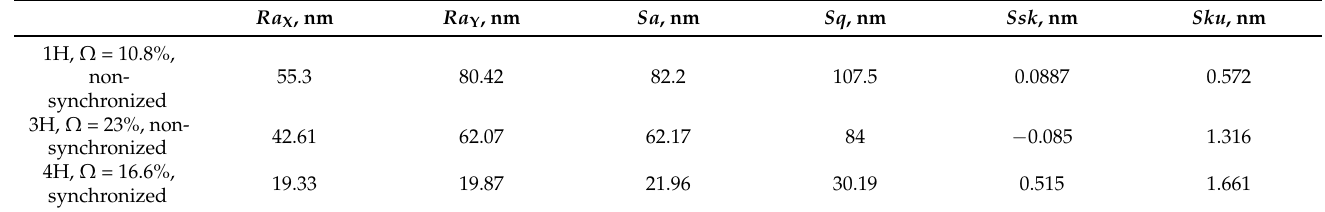
Table 2. Different surface roughness parameters of experimentally produced surfaces using different laser sources at optimal overlap values. Ra X and Ra Y —the arithmetic average height of a line averaged over the area in x and y directions, accordingly, Sa —surface arithmetic average height, Sq —RMS roughness of the surface, Ssk —surface skewness, Sku —surface kurtosis [19]. Ra X , nm Ra Y , nm Sa , nm Sq , nm Ssk , nm Sku , nm 1H, Ω =